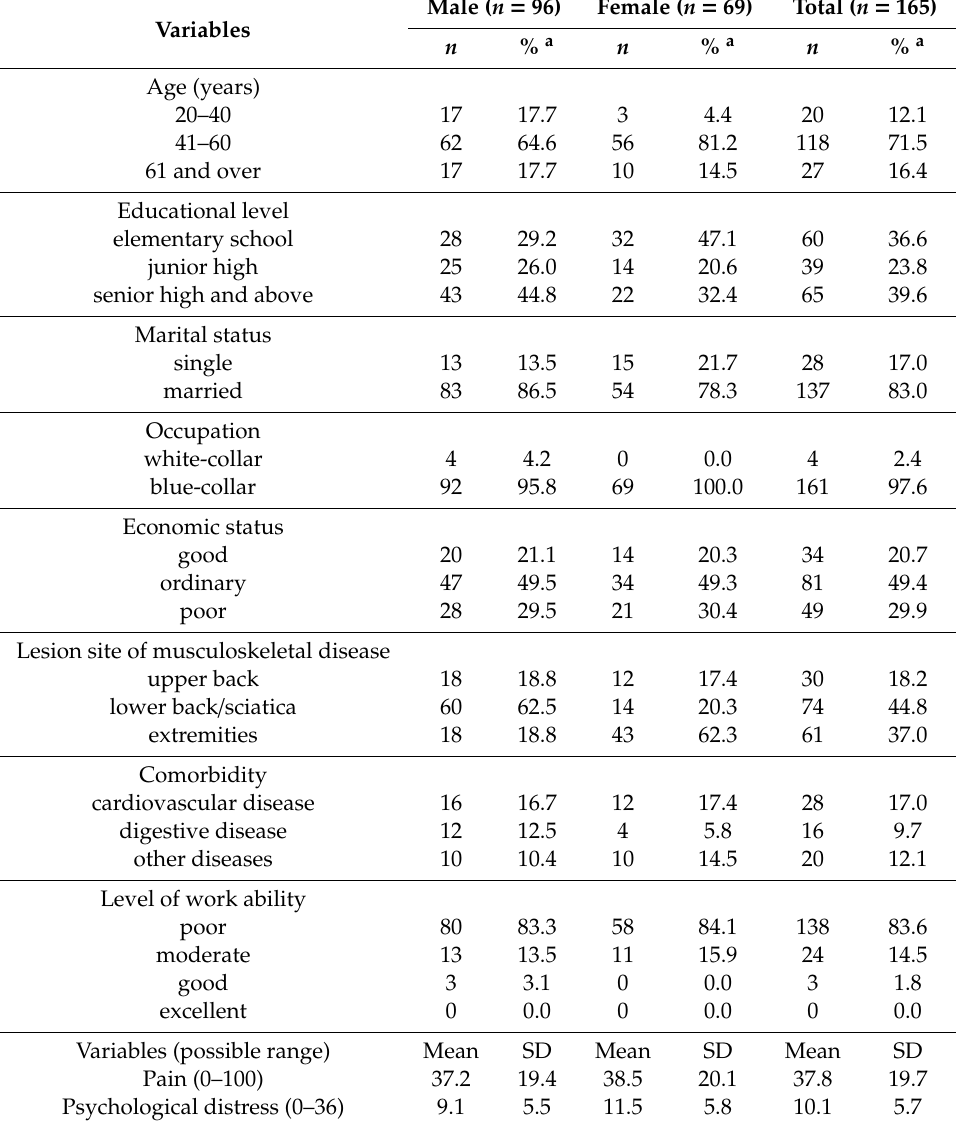
Table 1. The characteristics of the participants and the means of research